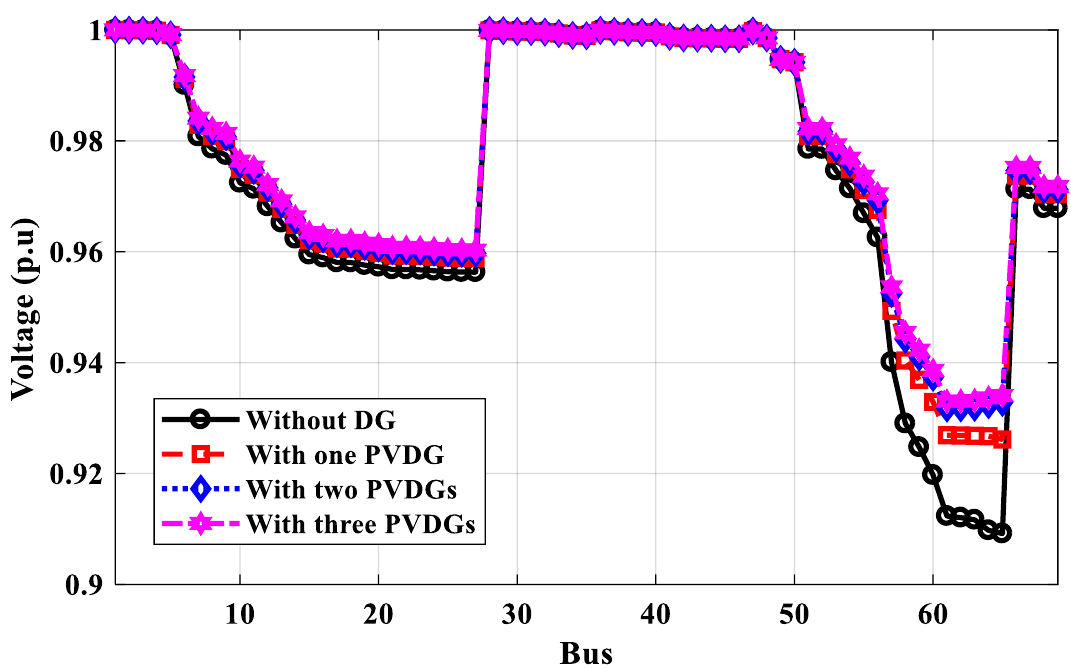
Figure 17. Voltage profile of IEEE 69-bus without and with PV system DGs for annual energy loss calculation.